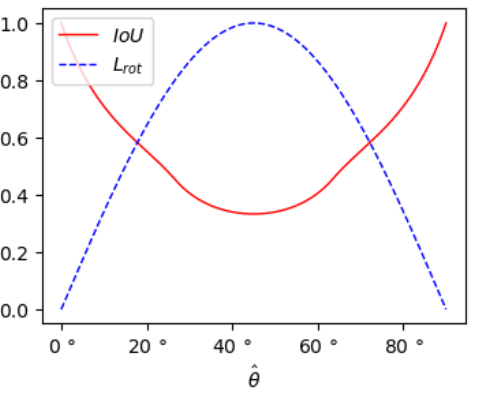
Figure 9. The curves of L rot and IoU with ˆ θ when the network predicts an inaccurate axis ˆ α and an accurate angle ˆ θ